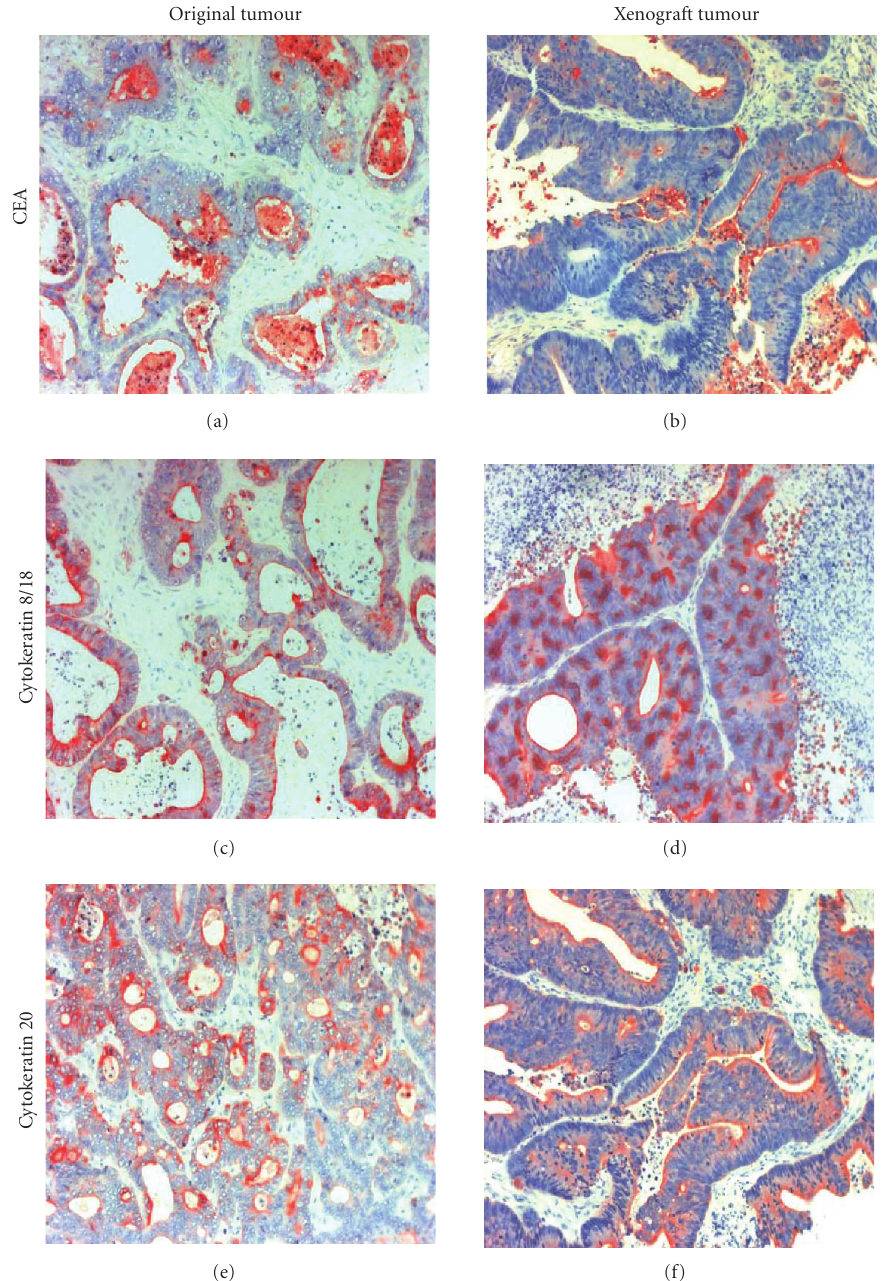
Figure 2: Immunohistochemical analysis of original and corresponding xenograft tumour KFJ6. Sections were stained with (a), (b) antibodies specific for CEA, (c), (d) cytokeratin 8/18, and (e), (f) cytokeratin 20. Magnification: